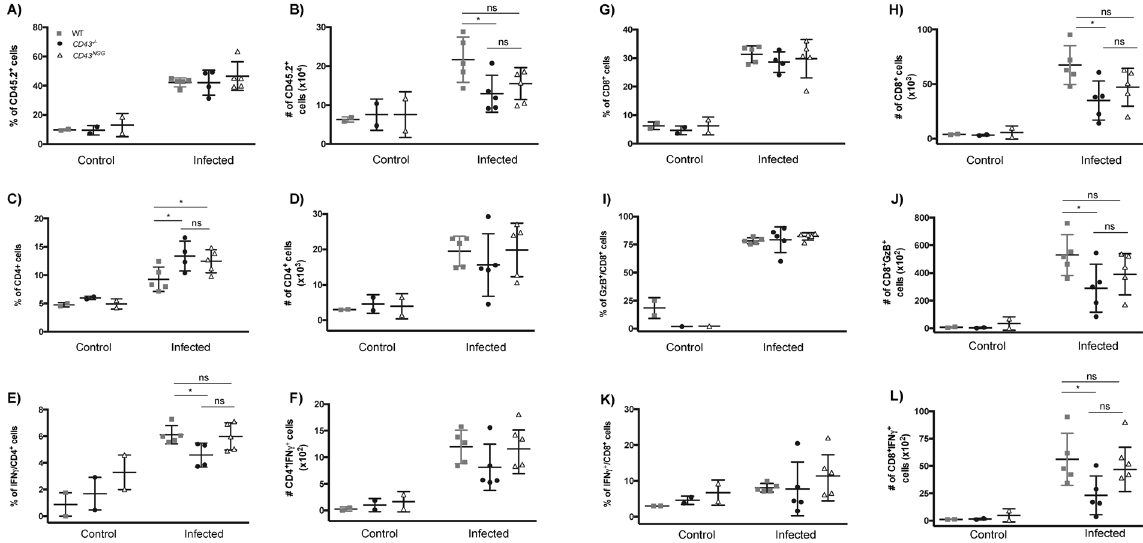
Figure 5. CD43 regulates migration of T cell subsets to the cardiac tissue of infected mice. Flow cytometry analyses for the relative frequencies of infiltrating T cells subsets obtained from cardiac tissue of control (non-infected) or infected mice by collagenase treatment. CD45.2 + ( A , B ), CD4 + ( C , D ), CD4 + IFN γ + ( E , F ), CD8 + ( G,H ) CD8 + GzB + ( I,J ) and CD8 + IFN γ + ( K,L ). Each cell population was analysed using the gating strategy presented in Fig.